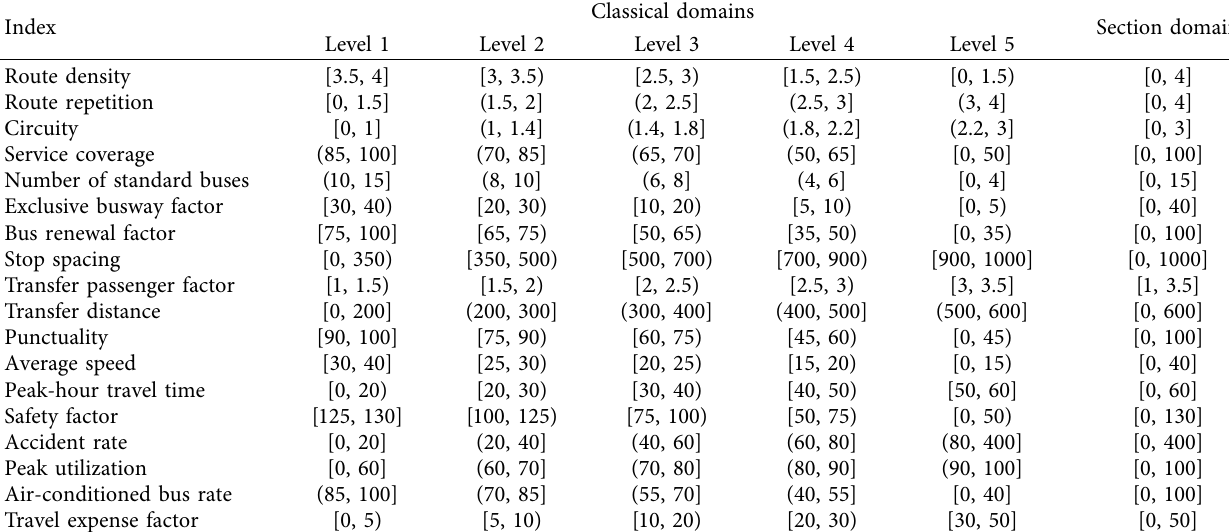
Table 3: Performance levels and associated indices under classical and section